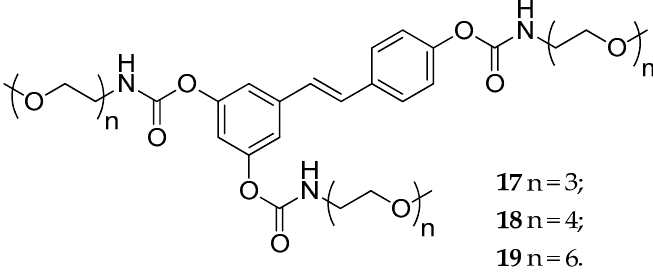
Figure 10. Chemical structures of methoxy-oligo(ethylene glycol)-carbamate substituted prodrugs, 17 – 19 .